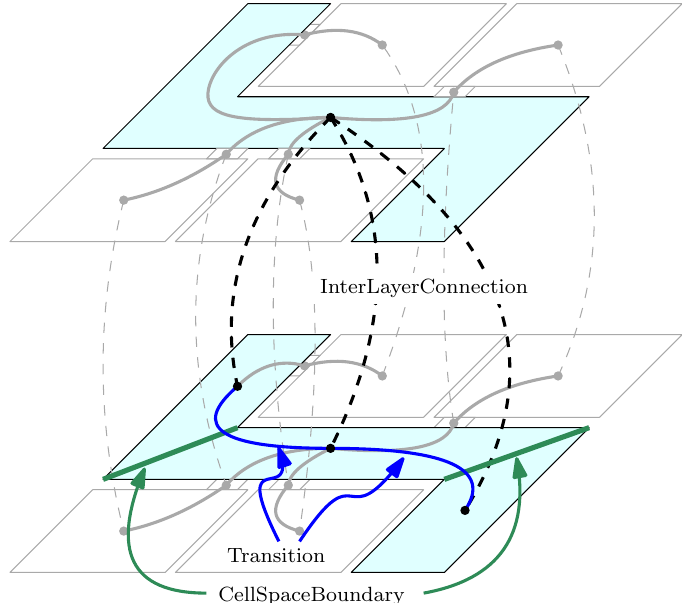
Figure 13. IndoorGML representation of a convex partition-based network for route